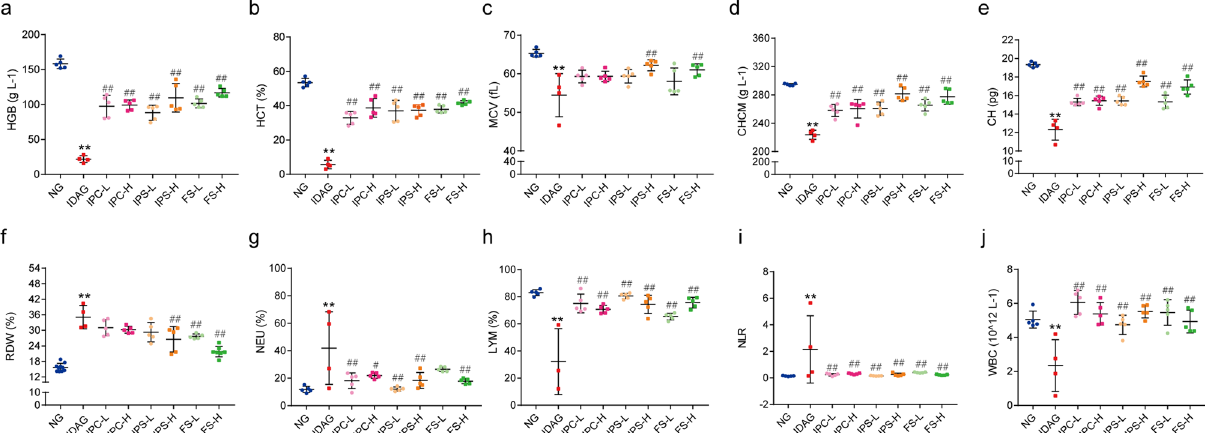
Figure 4. Haematological indexes of offspring rats after iron supplement treatment. The whole blood of offspring rats was collected and the haematological indexes were tested. ( a ) HGB. ( b ) HCT. ( c ) MCV. ( d ) CHCM. ( e ) CH. ( f ) RDW. ( g ) NEU. ( h ) LYM. ( i ) NLR. ( j ) WBC. HGB haemoglobin, HCT Hematocrit, MCV mean corpuscular volume, CHCM cell haemoglobin concentration mean, CH haemoglobin content of red blood cell, RDW red cell volume distribution width, NEU neutrophil, LYM lymphocyte, NLR neutrophil-to- lymphocyte ratio, WBC white blood cells count. Data are presented as mean ± SD ( n = 5). * p < 0.05, ** p < 0.01, compared with NG, # p < 0.05, ## p < 0.01, compared with IDAG. One-way ANOVA followed by Tukey multiple comparison test was used for comparison among 8 different groups.